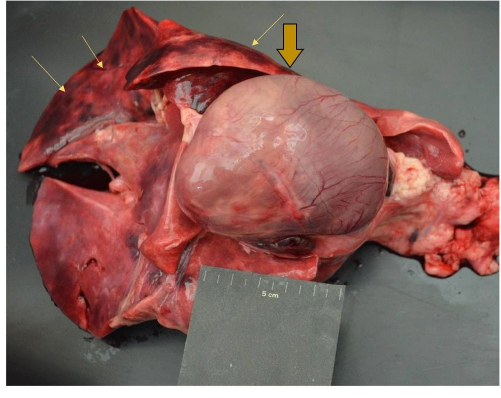
→→ Enlargement of cardiac right chambers; → Red-blue areas were in the right lobes of the lung. Figure 6. Postmortem examination of the dog which died due to heartworm infection of heart and lungs showing enlargement of cardiac right chambers and red-blue areas in the right lobes of the